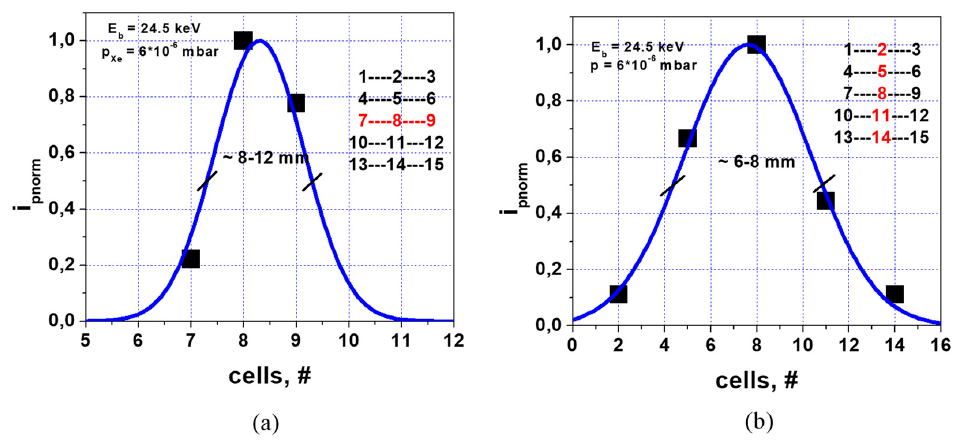
Figure 13. Normalized profiles of Xe + primary ions on primary beam detector in Y ( a ) and X ( b ) directions.